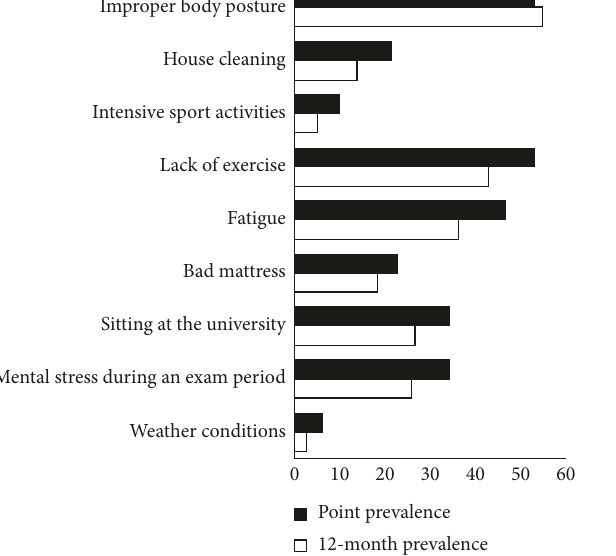
Figure 1: Self-perceived subjective triggers with strong/extremely strong impact on low back pain among medical students.